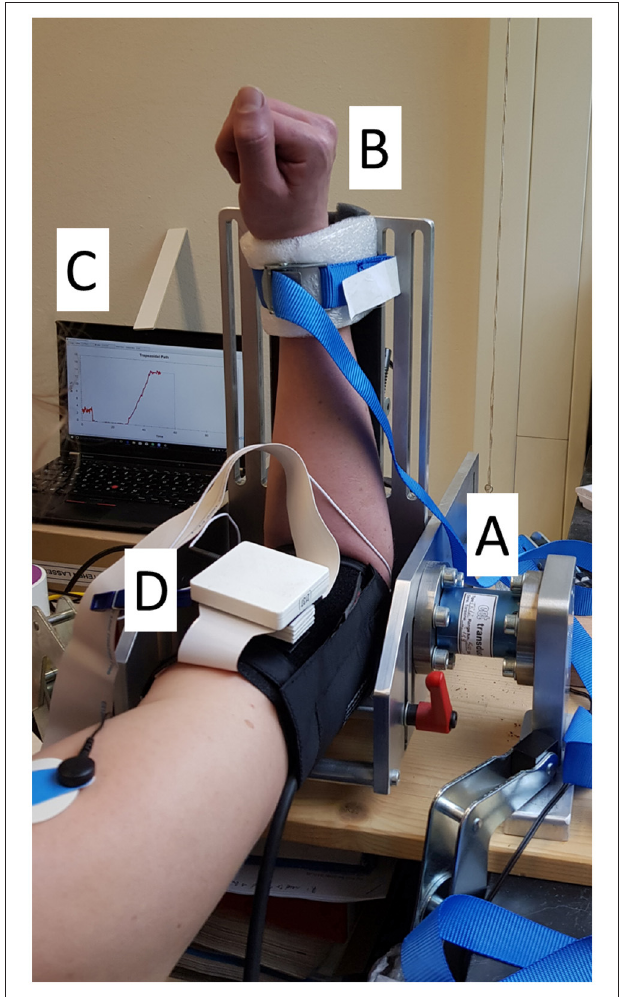
FIGURE 1 | Experimental setup. The subject placed their right arm in the ALF apparatus (A) and were secured with an inextensible strap, softened by a foam cushion (B) . On the left it is possible to observe the visual feedback screen (C) . The HDEMG array was placed underneath the blood pressure cuff (only the pre-amplifier is visible in the picture, (D)